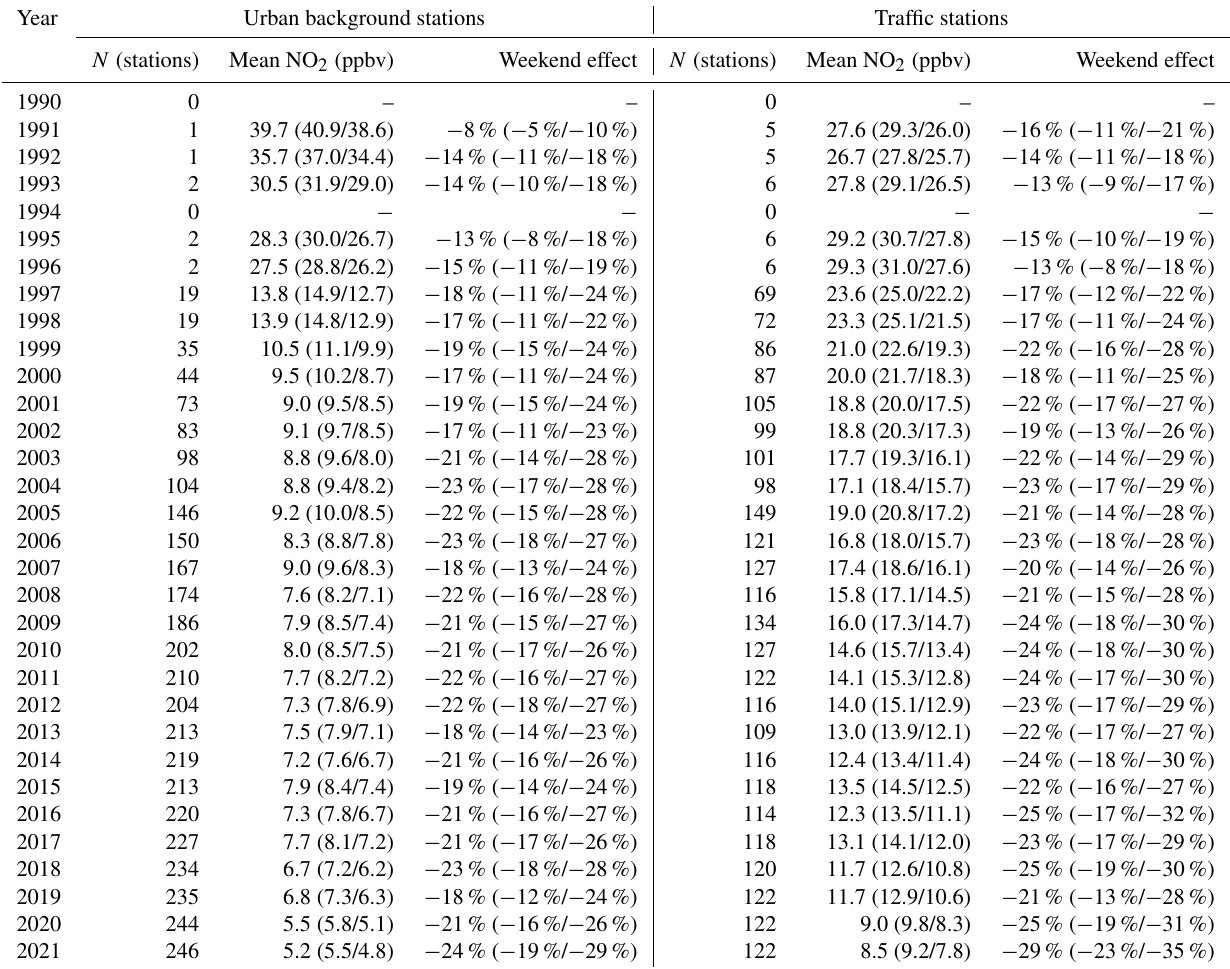
Table G2. Annual evolution of the entire weekend (as well as Saturday/Sunday taken individually, in parentheses) mean surface NO 2 mixing ratios and change, relative to weekdays (Monday to Friday), over the period 1990–2021 in